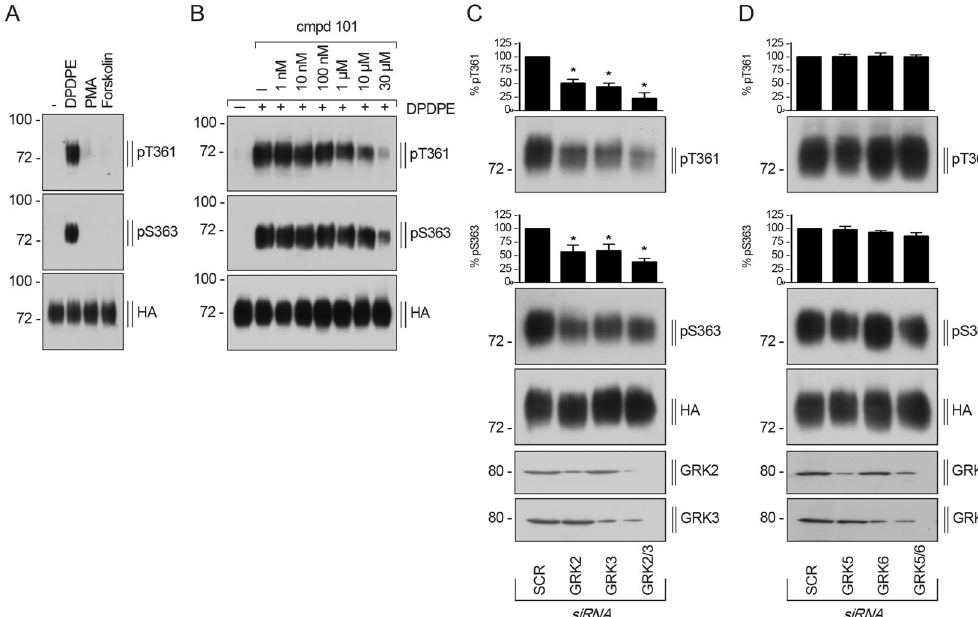
Figure 3. DPDPE-induced DOP receptor phosphorylation is mediated by GRK2 and GRK3. ( A ) HEK293 cells stably expressing HA-hDOP receptor were stimulated with 1 µ M DPDPE, 1 µ M PMA or 10 µ M forskolin for 10 min at 37 °C. Cell lysates were immunoblotted with anti-pT361 or anti-pS363 antibodies. Blots were stripped and reprobed with the anti-HA antibody as loading control. Blots are representative, n = 4. (B) Cells described in ( A ) were preincubated with either vehicle (DMSO; -) or compound (cmpd) 101 at the indicated concentrations for 30 min at 37 °C, then treated with buffer or 1 µ M DPDPE for 10 min at 37 °C. Lysates were immunoblotted as described in ( A ). Blots are representative, n = 3. (C,D) Cells described in ( A ) were transfected with siRNA targeted either to (C) GRK2, GRK3, or GRK2 and GRK3 (GRK2/3), (D) GRK5, GRK6, or GRK5 and GRK6 (GRK5/GRK6), or non-silencing siRNA control (SCR) for 72 h, then stimulated with1 µ M DPDPE for 10 min at 37 °C. Lysates were immunoblotted as described in (A). Knock down of GRKs was confirmed by Western blot (bottom panels in C and D). Densitometry readings, above the blots, were normalized to SCR (control) transfected cells, which were set to 100%. Data are means ± SEM from three to